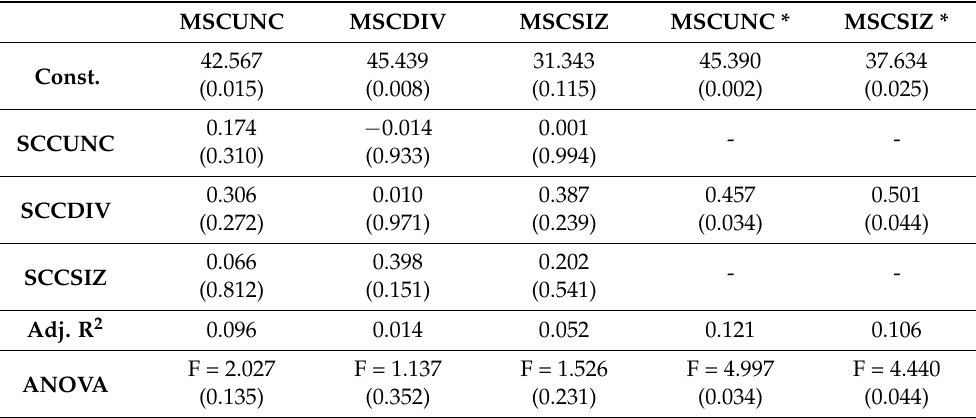
Table A3. Analysis for factors of 4PL Customer Benefits